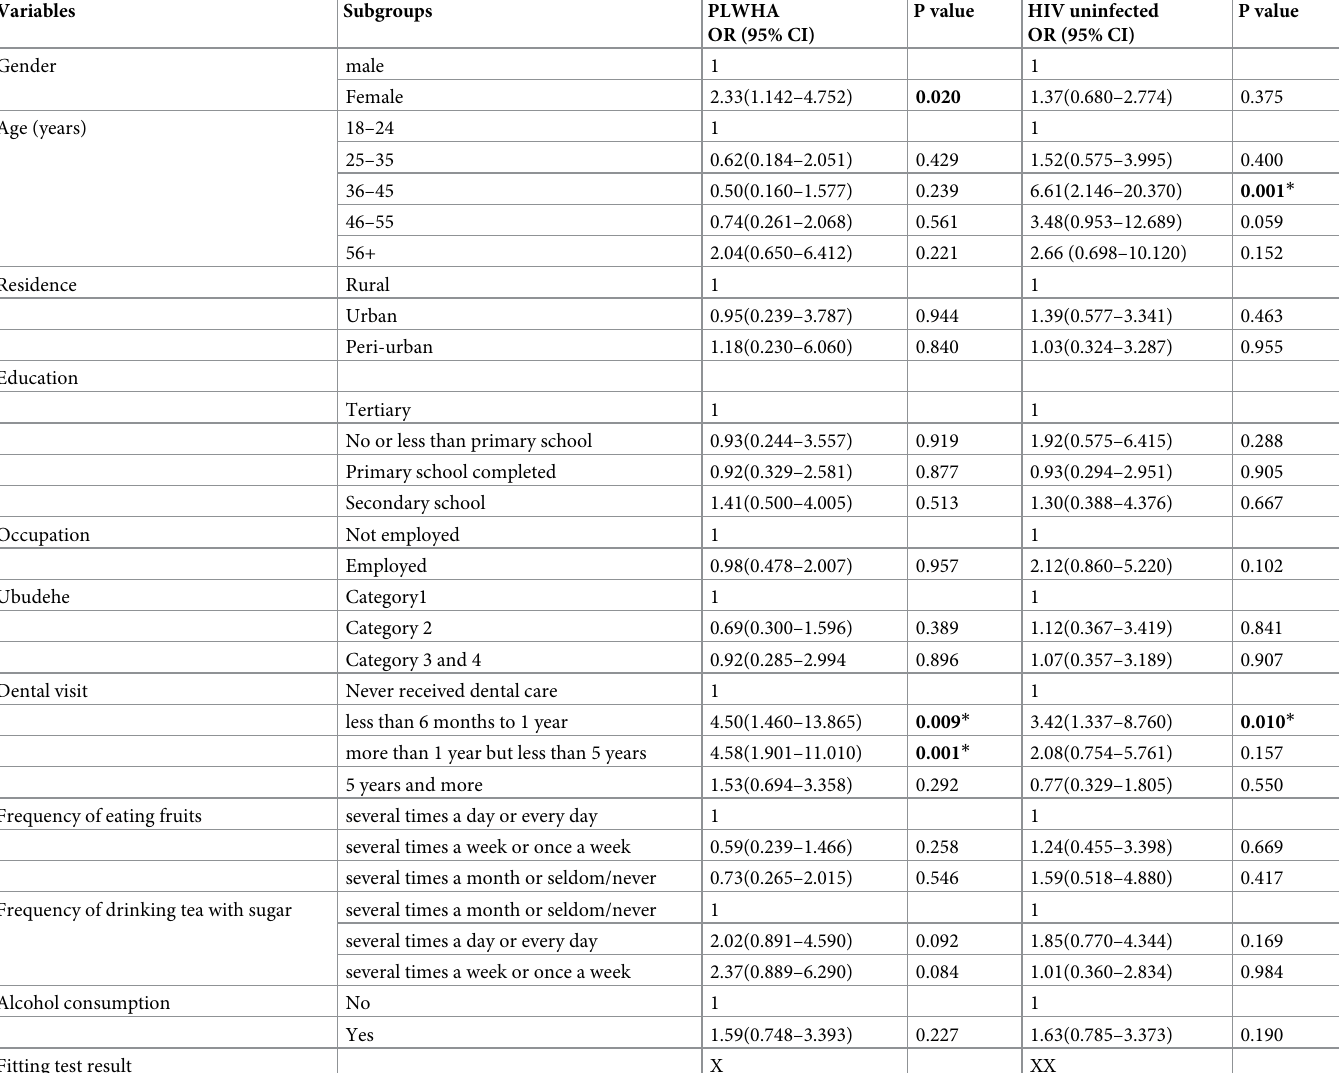
Table 3. +Comparison of factors associated with dental caries among participants according to HIV